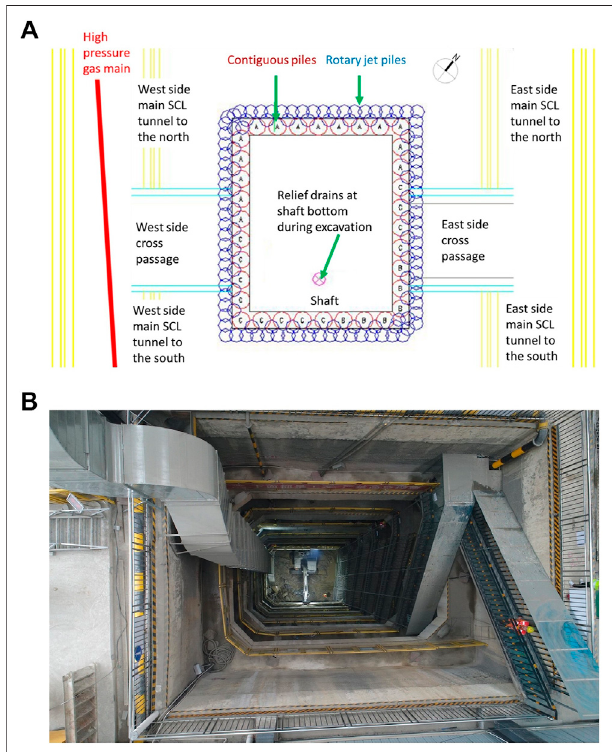
FIGURE 3 | Plan view of underground structures on site: (A) drawing plan; (B) completed view.